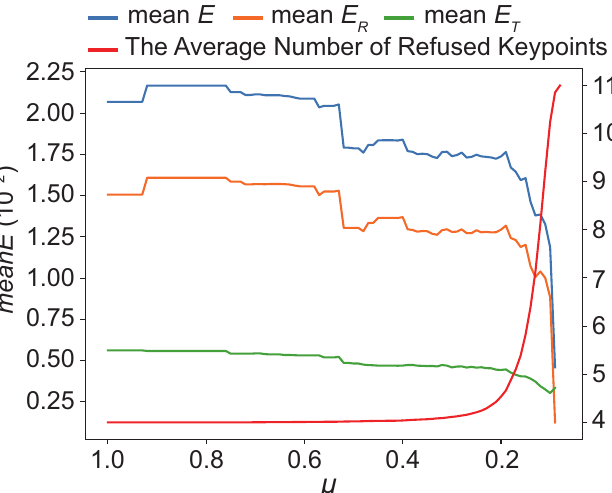
Figure 9. The meanE and Number of Refused Images with Different µ